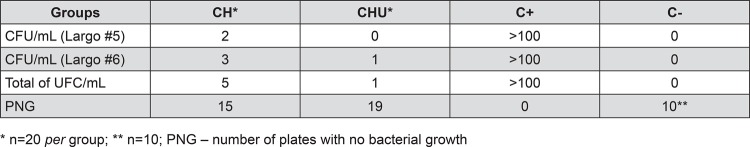
 Amount of CFU/mL per group after collection with Largo burs #5 and #6; amount of total CFU/mL and amount of plates that did not present bacterial growth